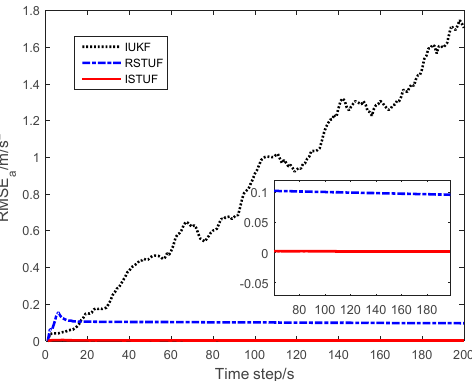
Figure 8. RMSE of estimating acceleration.